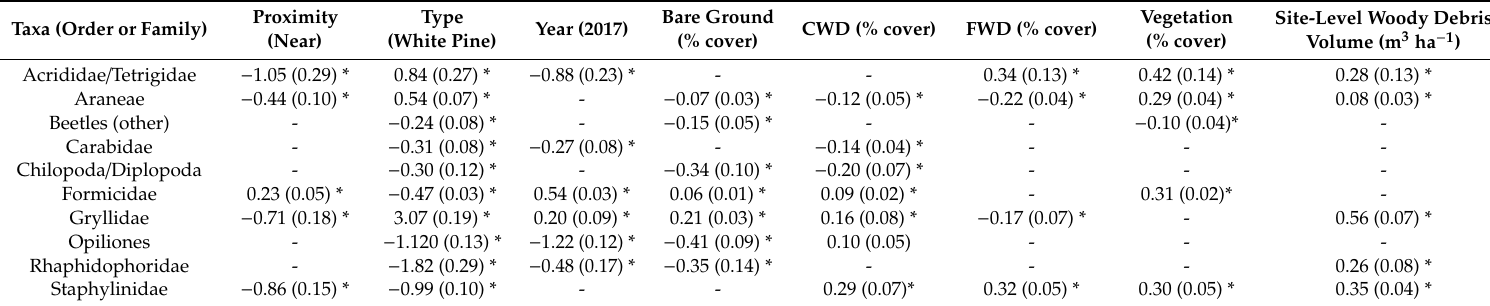
Table 4. Coe ffi cients for the relationship between number of captures of each invertebrate taxa and the habitat covariates (bare ground, coarse woody debris (CWD), fine woody debris (FWD), vegetation, and woody debris volume) included in the most competitive linear regression model based on captures at 10 harvested locations in western North Carolina USA (2016–2017). Standard errors are noted in parentheses. A “ − ” means that the specific variable was not included in the top model for the taxa. * Indicates p -value < 0.05.